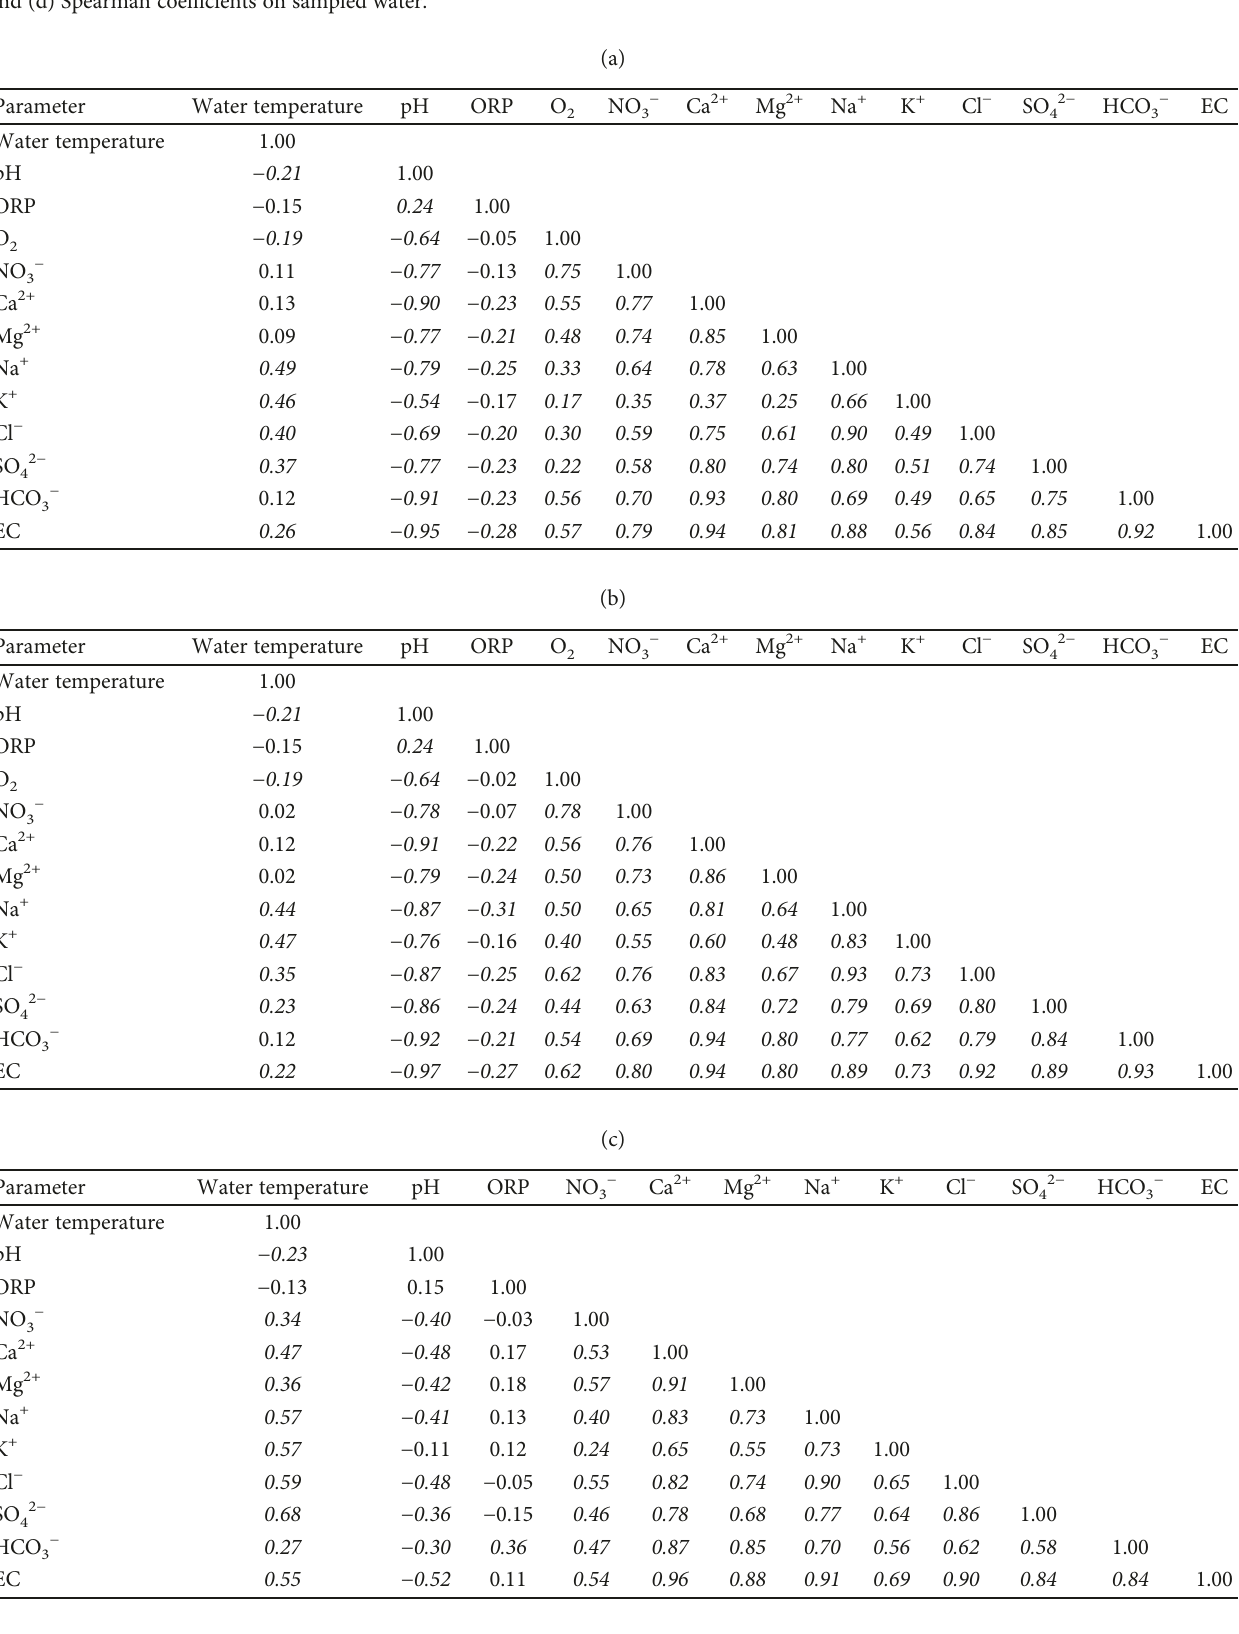
Table 1: Correlation result matrices (statistically signi fi cant correlation coe ffi cients are marked in italics): (a) Pearson coe ffi cients on historical groundwater analysis, (b) Spearman coe ffi cients on historical groundwater analysis, (c) Pearson coe ffi cients on sampled water, and (d) Spearman coe ffi cients on sampled